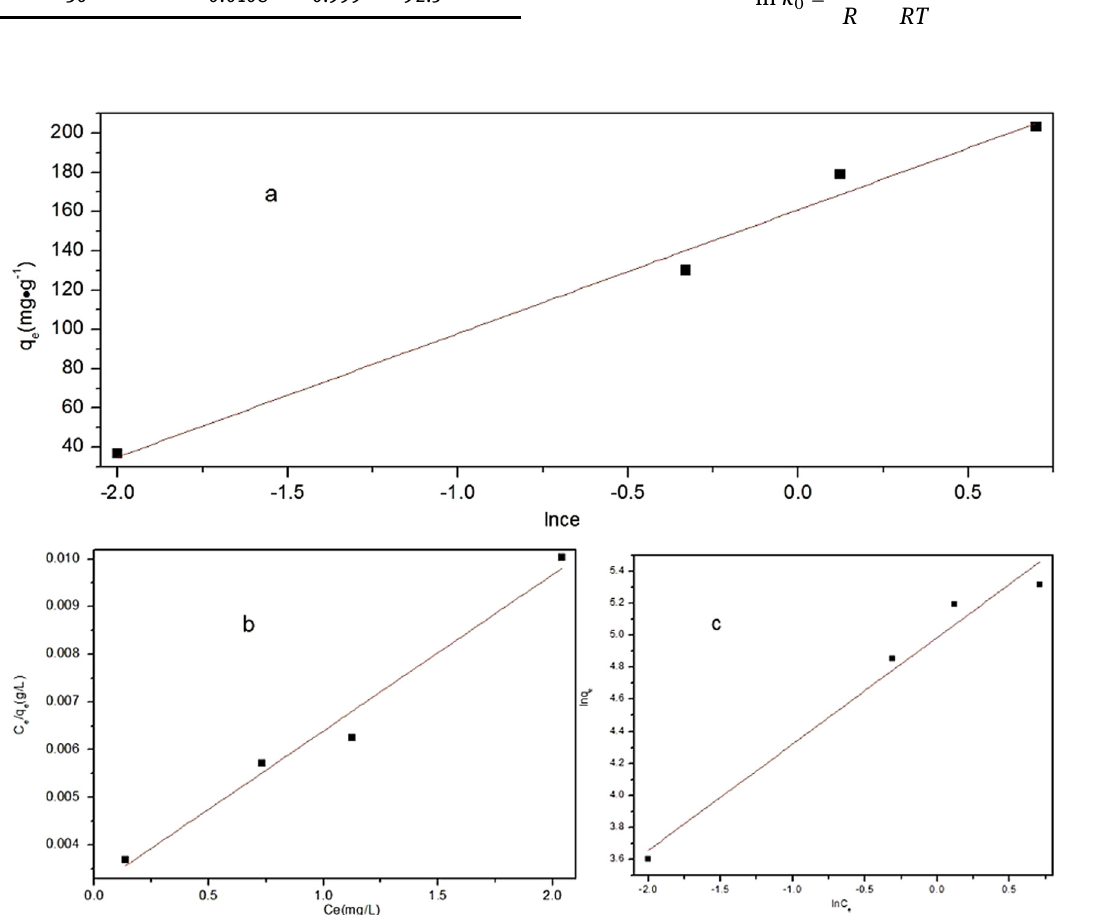
Figure 6: Adsorption isotherms of CR onto Sm - MOFs at room temperature: ( a ) Temkin isotherm, ( b ) Langmuir isotherm, and ( c ) Freundlich